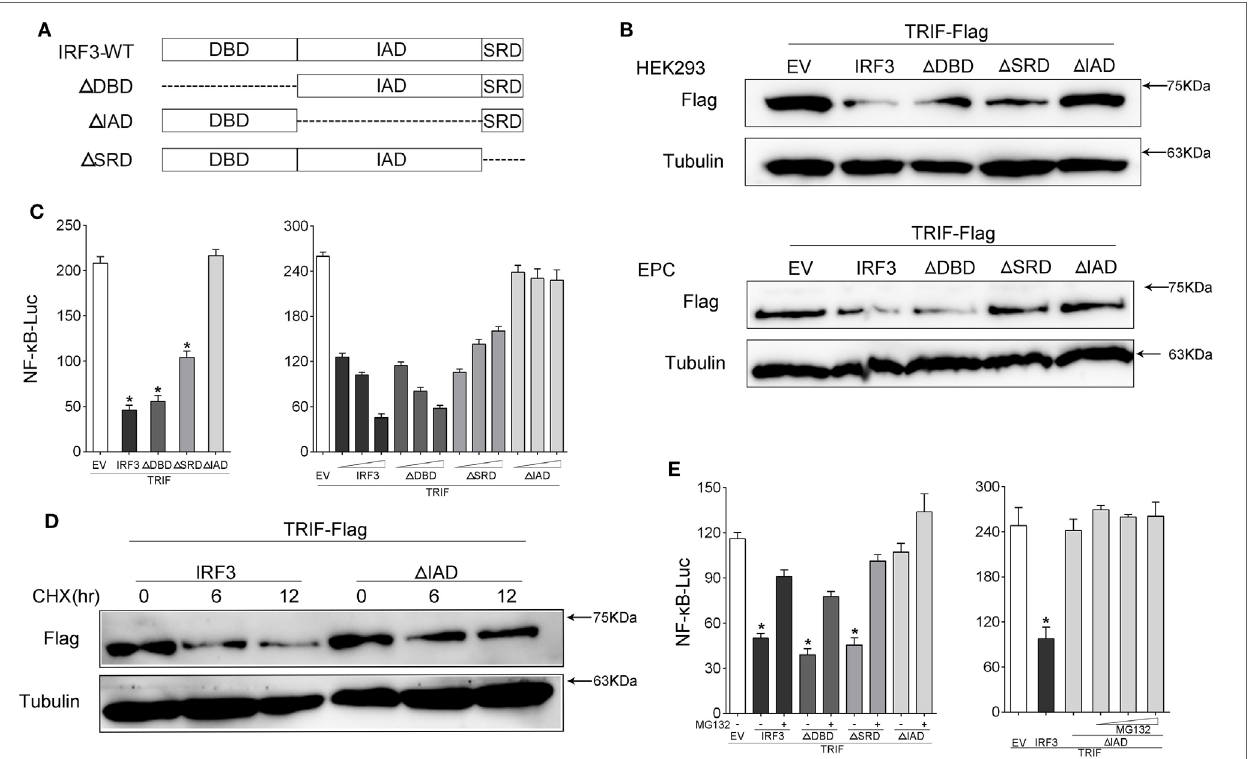
FigUre 8 | IRF association domain (IAD) of IRF3 is critical for TRIF degradation. (a) Schematic diagram of WT and mutants of IRF3 plasmids. (B) HEK293 and EPC cells were co-transfected with IRF3, Δ DNA binding domain (DBD), Δ IAD, or Δ SRD, respectively, together with TRIF, after 48 h, TRIF protein levels was determined by immunoblot assays and normalized to tubulin. (c) HEK293 cells were co-transfected with TRIF, IRF3, Δ DBD, Δ SRD, Δ IAD, or a different concentration IRF3 and the above mutant’s plasmid, together with NF- κ B reporter gene. At 48 h post-transfection, the luciferase activity was measured. (D) HEK293 cells were co-transfected with TRIF and IRF3 or Δ IAD plasmids, after 36 h, the cells were treated with cycloheximide (100 µg/ml) for different times, then TRIF protein levels were determined by immunoblot assays and normalized to tubulin. (e) HEK293 cells were co-transfected with TRIF, IRF3, Δ DBD, Δ IAD, or Δ SRD respectively, together with NF- κ B, after 36 h, the cells were treated with DMSO or 10 µM MG132 or concentration gradient MG132 (5, 10, and 15 μ M) for 12 h, then the luciferase activity was measured. The luciferase activity value was achieved against the Renilla luciferase activity. * p < 0.05 versus the